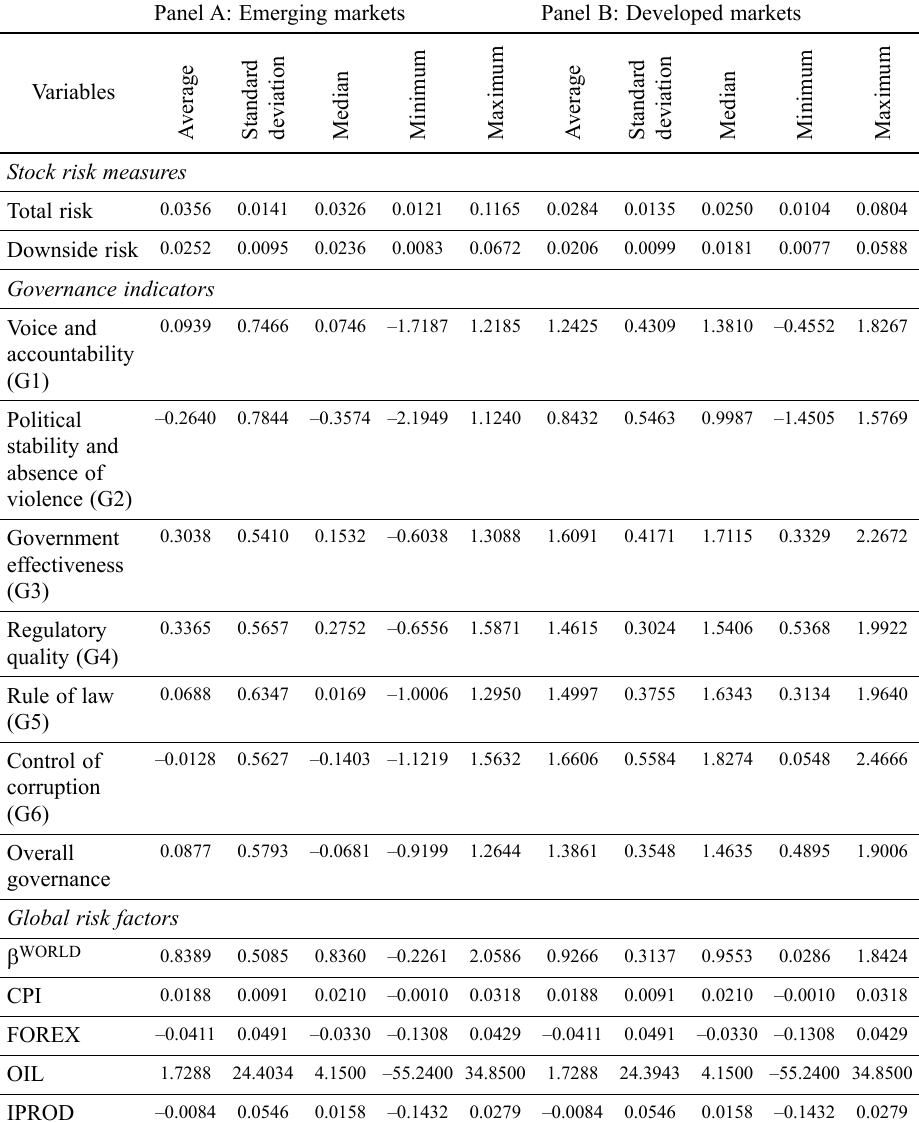
Table 2. Descriptive statistics from January 2002 through December 2009 Panel A: Emerging markets Panel B: Developed